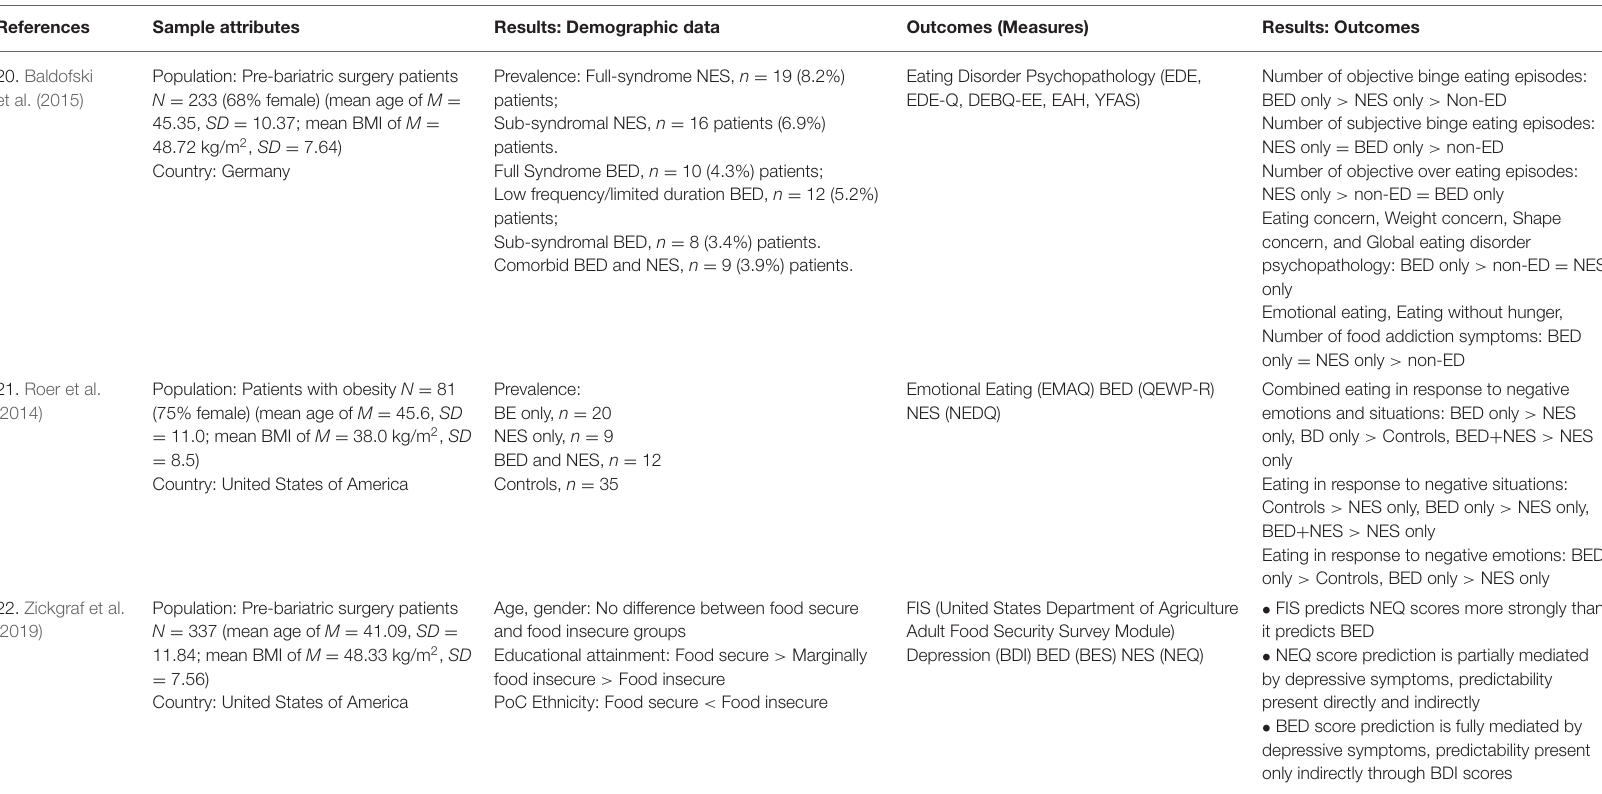
TABLE 2 | Studies investigating the differences and similarities between NES and BED in patients with eating disorder(s), obesity, and/or undergoing bariatric